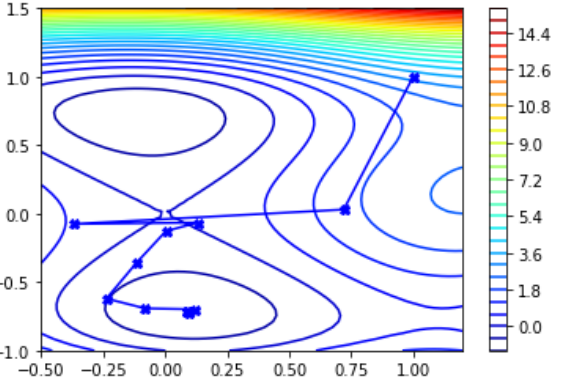
Figure 14. Global minima of SIX-HUMP CAMEL function using q -BFGS algorithm. Table 4. Numerical results for BFGS algorithm.